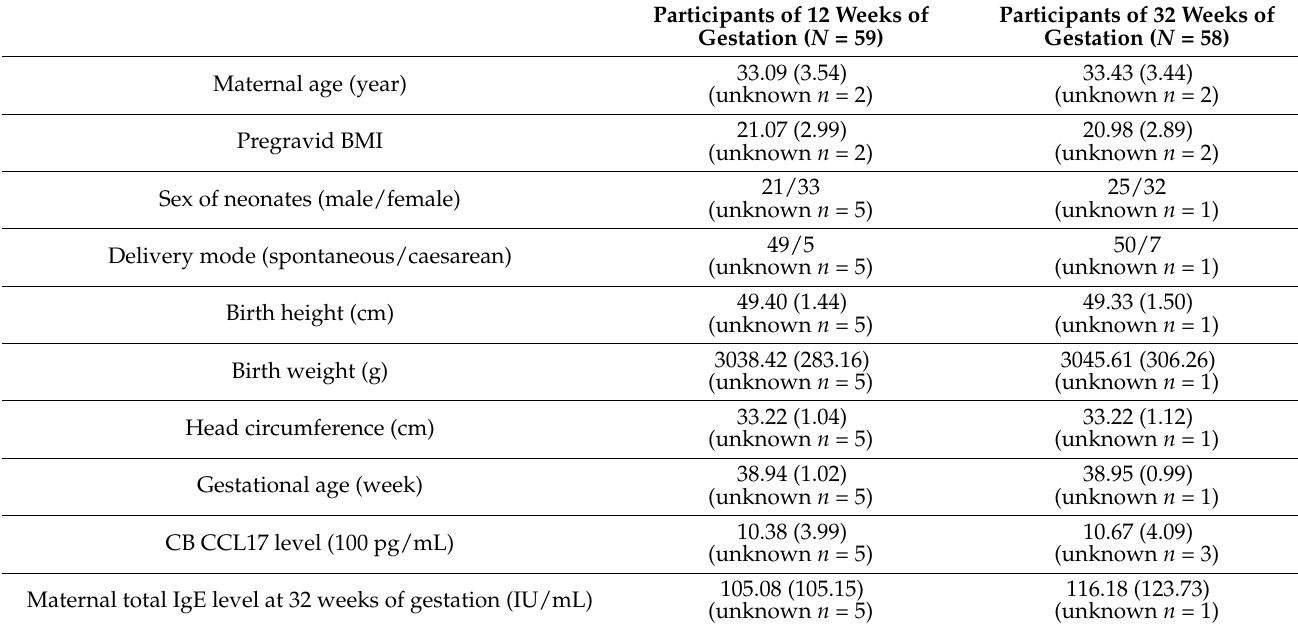
Table 1. Demographic data (mean ± SD) of the study population.